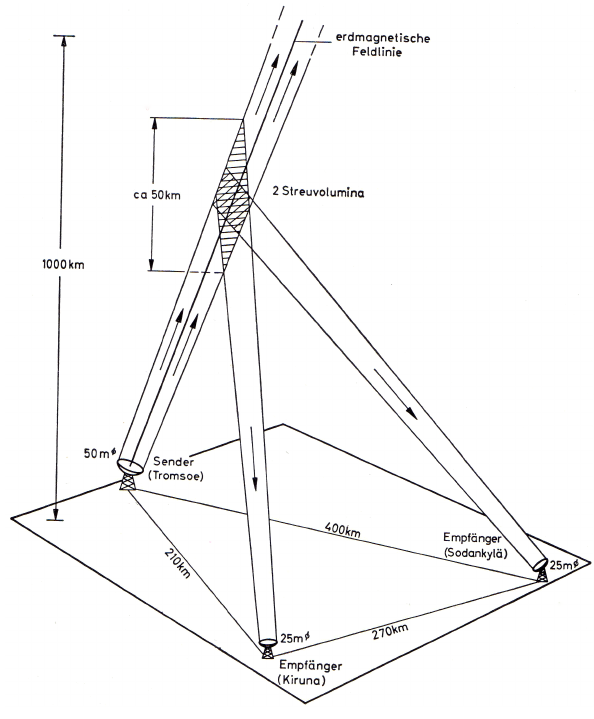
Figure 1. EISCAT configuration after H. Kohl (1972). It should be noted that in this figure a fixed dish of 50m diameter was suggested for the transmitter site. This concept was substantially changed at a later time due to Ian Axford’s intervention in favor of a fully steer- able